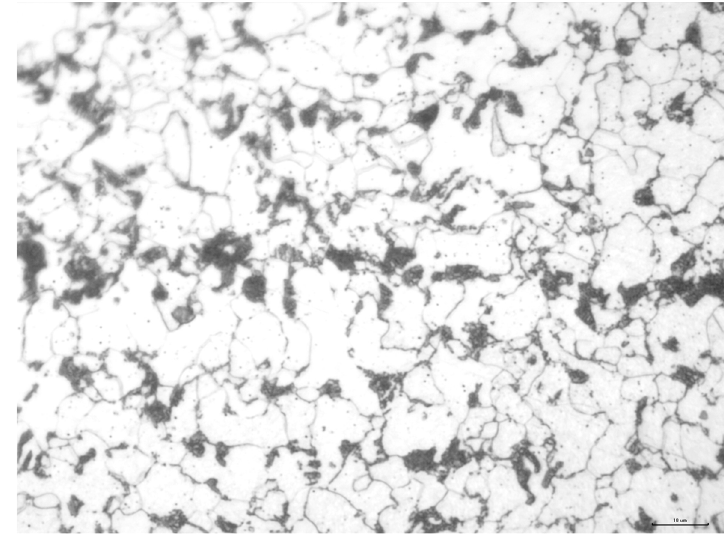
Fig. 32 A Pipe inner surface